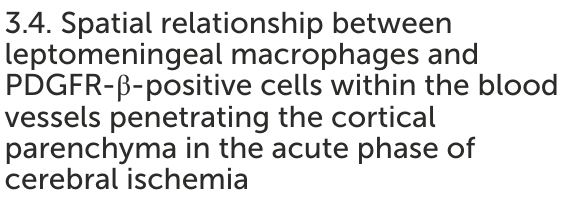
Bonney et al., 2022; Dorrier et al., 2022). As indicated